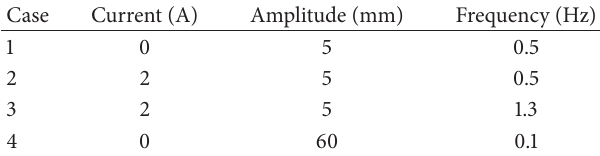
Figure 7: Various temperatures of an MR damper with case 1 and case